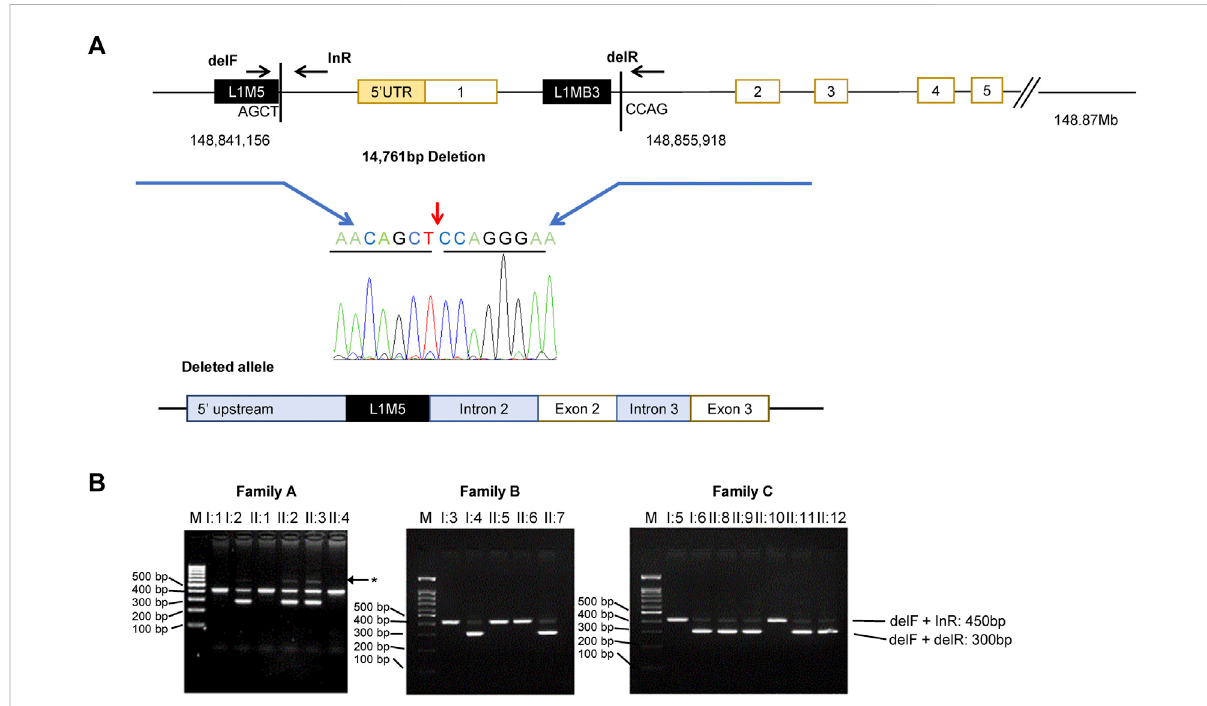
Identi fi cation of a large deletion in HPS3 . (A) Top: Scheme of the HPS3 deletion and multiplex PCR ampli fi cation assay with three primers: delF and delR across the deletion and inR within the deletion. Chromatogram of the deletion breakpoint sequence. Bottom: Schematic basis of the deleted allele, which shows deletion of the 5 ′ UTR and exon 1. The deletion occurs between two LINE-1 repeats (black box). (B) Multiplex PCR ampli fi